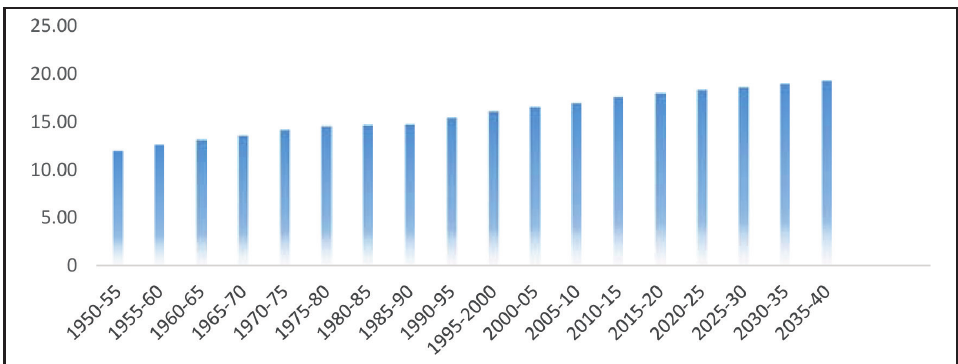
Life expectancy in India by age ≥60 years